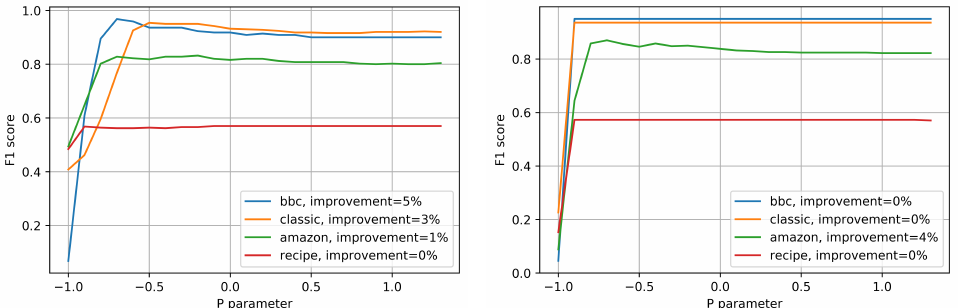
Figure 3. Representation of the GTSM method’s P parameter behaviour: ( left ) for word2vec; ( right ) for co-ocurrence